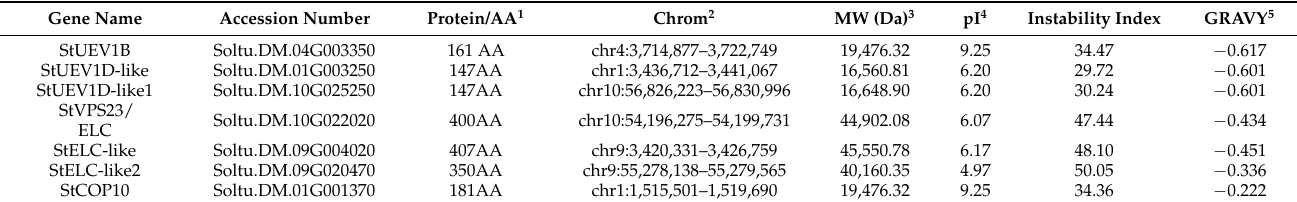
Table 1. List of the identified StUEVs genes and related